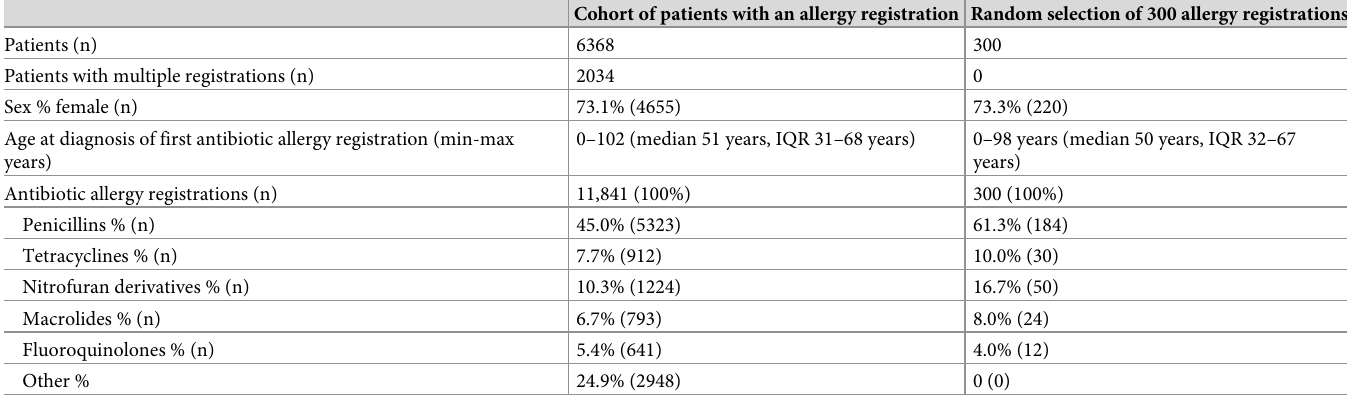
Table 1. Characteristics of patients with an antibiotic allergy registration. Cohort of patients with an allergy registration Random selection of 300 allergy